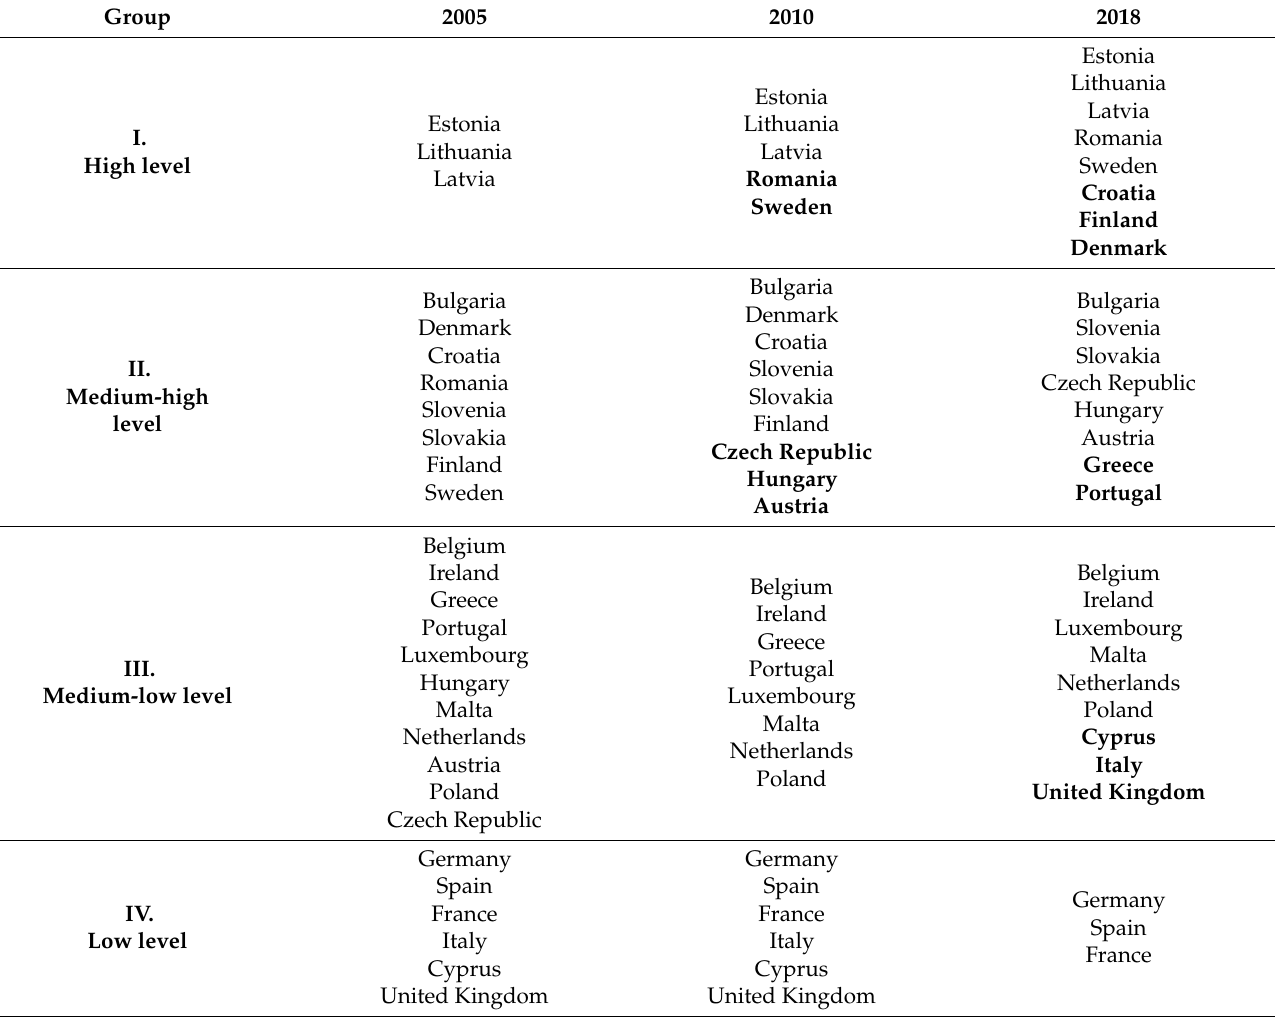
Table 5. Distribution of countries into individual groups according to the performance of the synthetic measure.